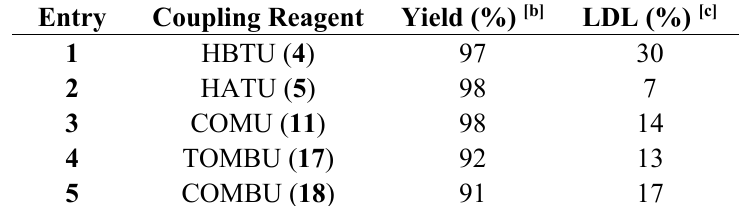
Table 4. Yield and racemization during the formation of Z-Phe-Val-Pro-NH 2 ( 25 ) (solution-phase synthesis) [a]